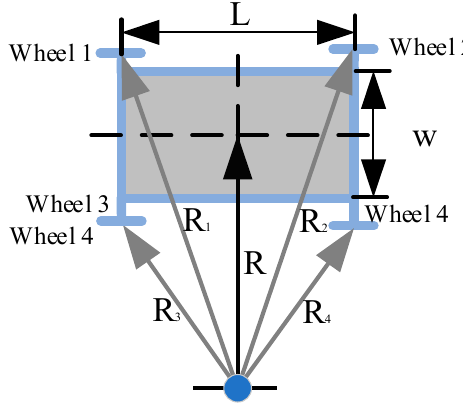
Figure 3. Schematic diagram of four-wheel AGV turning radius.